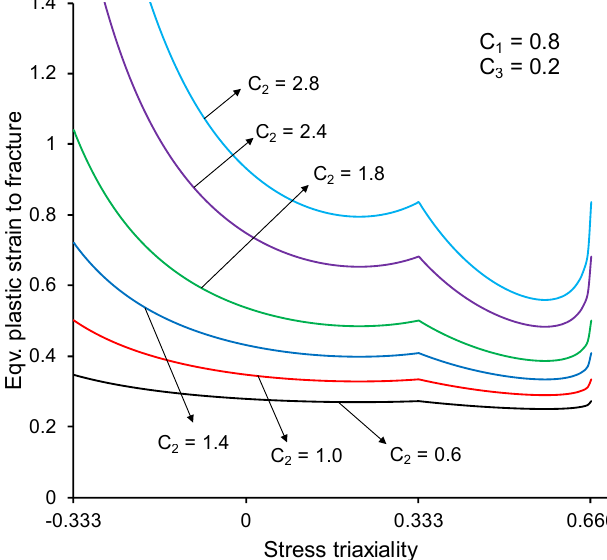
Figure 5. Effect of C 2 on the proposed fracture model for C 1 = 0.8, C 3 = 0.2.